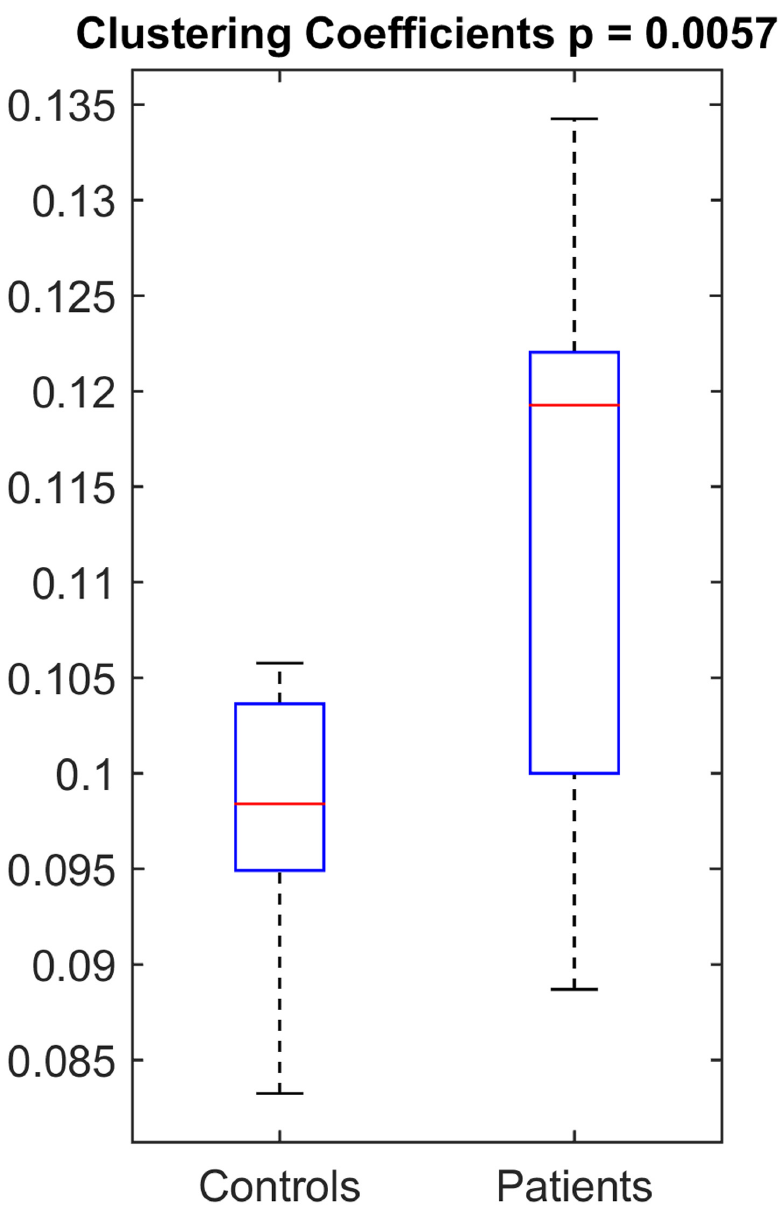
Fig 6. The distribution of clustering coefficient of PDC in beta band as a box-plot in patients vs. controls, showing the median and interquartile